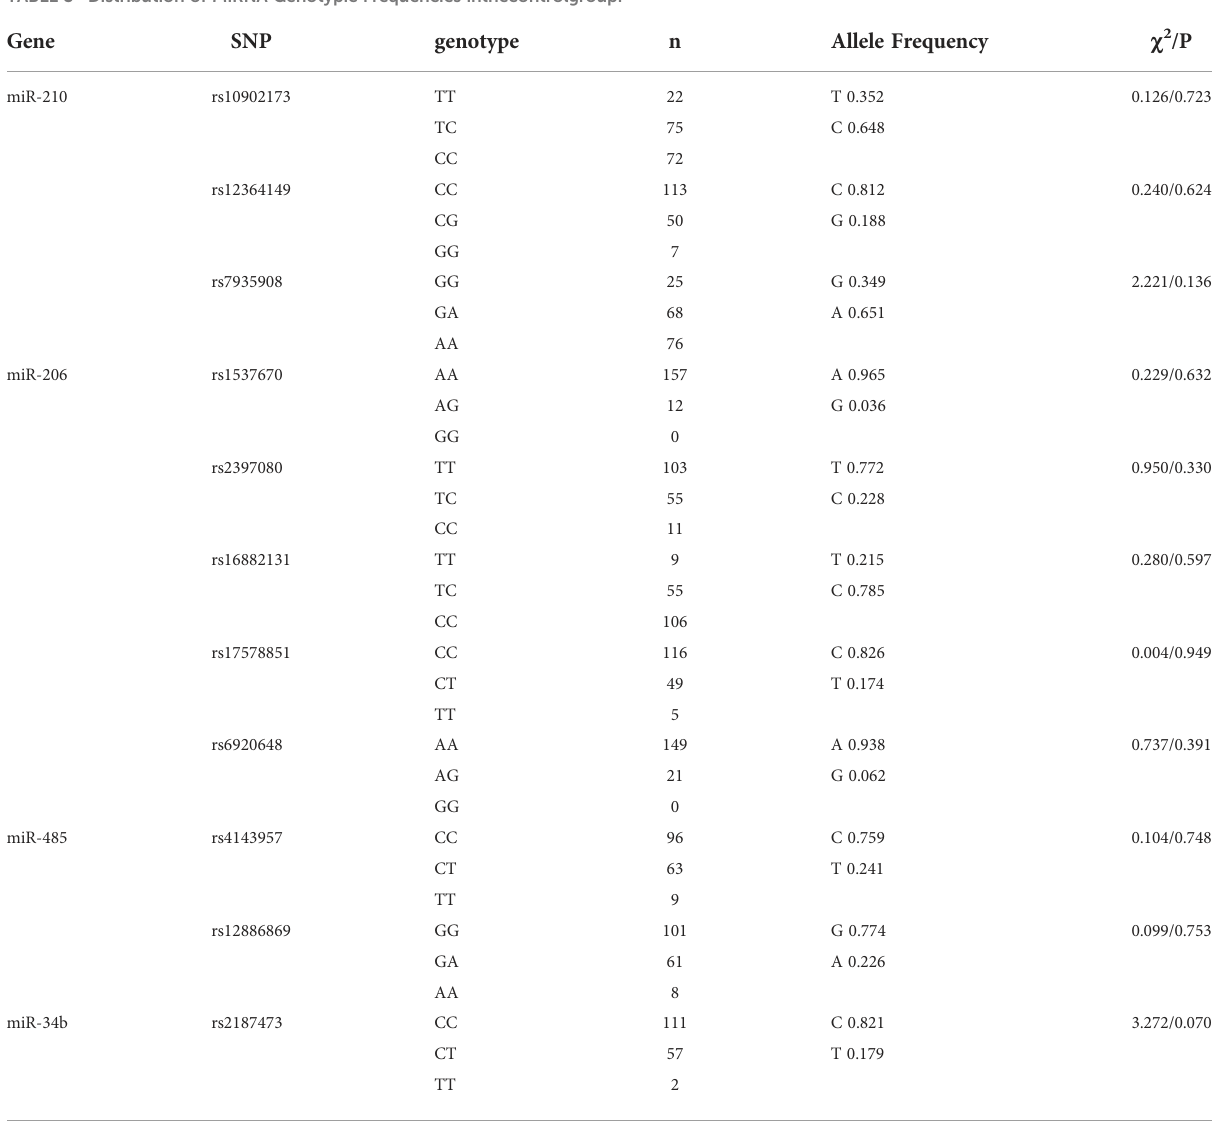
TABLE 3 Distribution of MiRNA Genotypic Frequencies